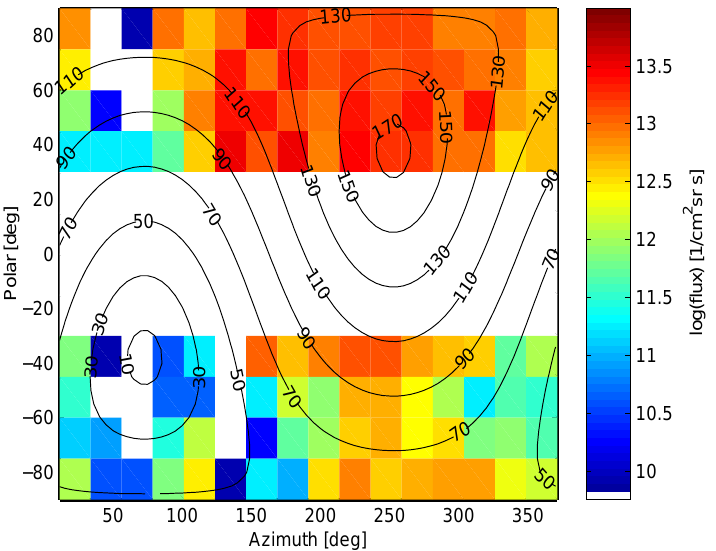
Fig. 4. Angular distribution of protons in GSE coordinates in 22:55:21–22:57:29 UT (the burst noted in Fig. 2). The angles represent the flow direction of the particles. The maximum fluxes are observed coming from duskward of the Sun-Earth line, while very low fluxes are observed coming from the opposite direction. The empty area between polar angles from –30 ◦ to 30 ◦ is due to the corrupted central sensor heads of the RAPID IIMS instrument. Pitch angle contours corresponding to average magnetic field B GSE =(9.7, 31, –25)nT observed by C4 are also